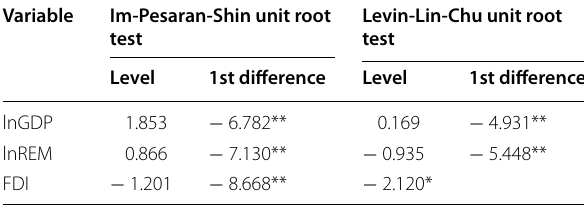
**, * denotes 1% and 5% significant level, respectively